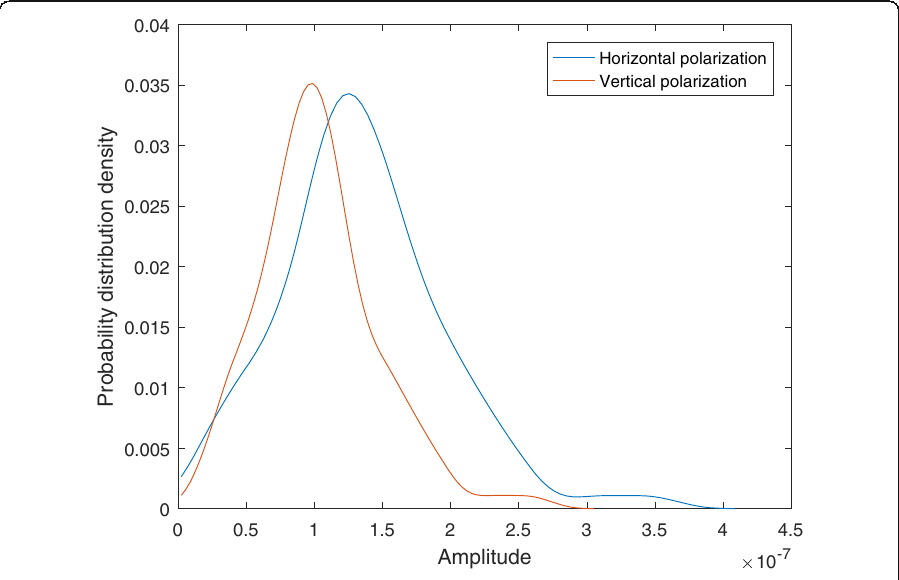
Fig. 4 Amplitude probability distribution